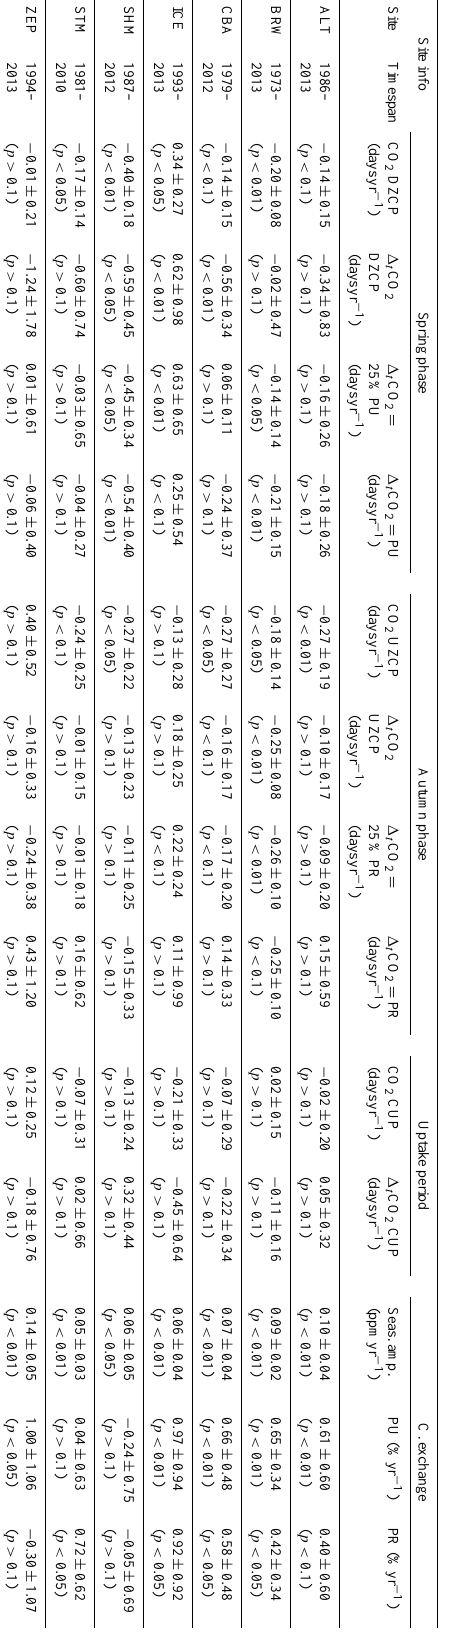
served variation in CO 2 seasonal amplitudes at high northern